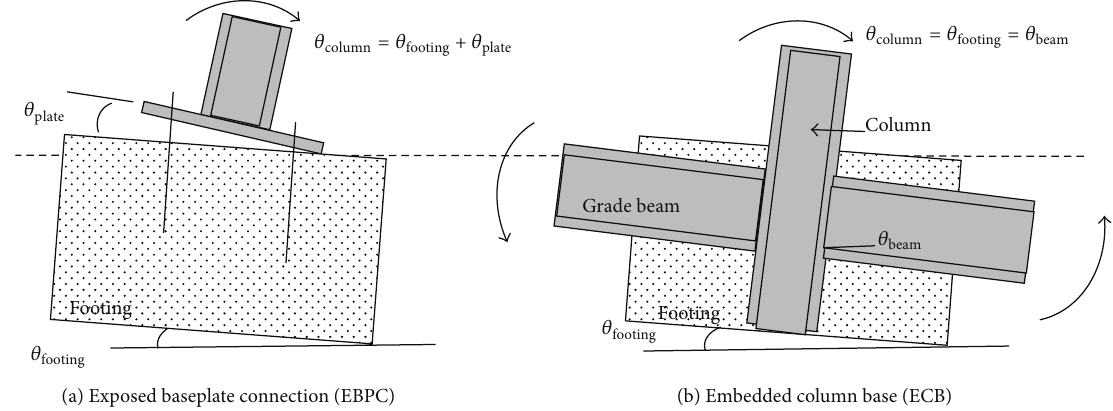
Figure 2: Common base connections (Zareian and Kanvinde [4]).